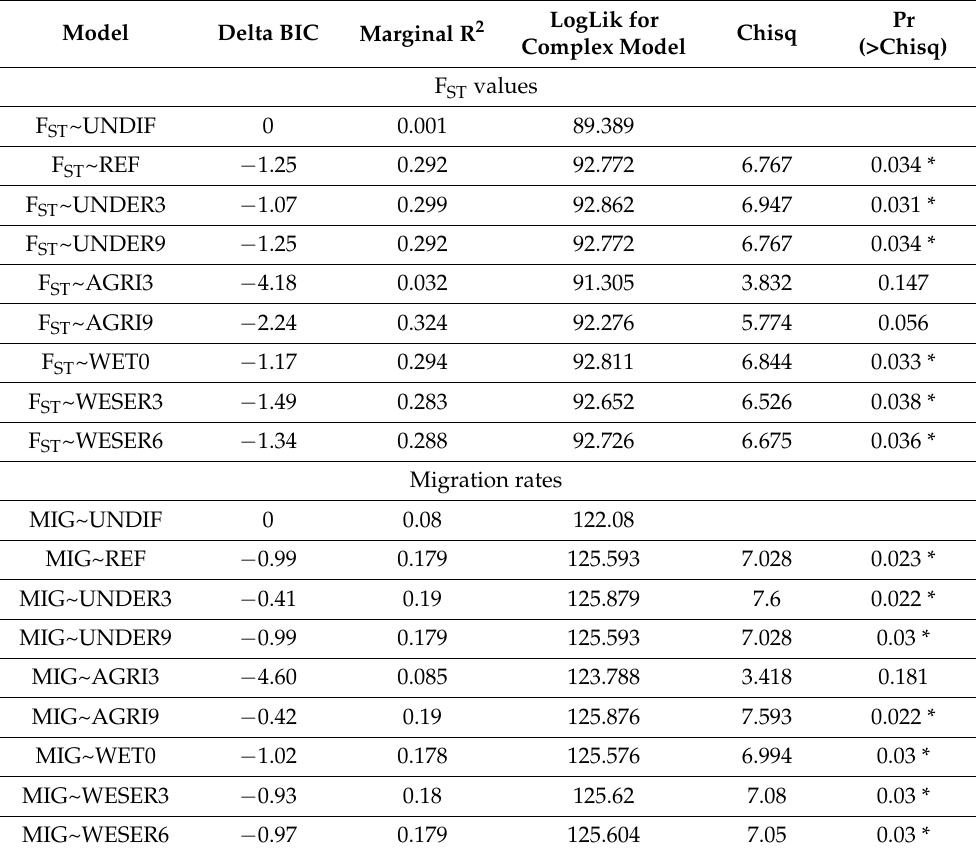
Table 4. Model selection analysis with delta Bayesian Information Criterion (“BIC”) and marginal R 2 as indicators showing the effects of different landscape structure models on population differentiation (F ST ) and migration rate (“mig”) for pairs of B. variegata subpopulations. LogLik for complex models was calculated between each model and an undifferentiated landscape (“UNDIF”). * indicates significant Pr values < 0.05. LogLik Model Delta BIC Marginal R 2